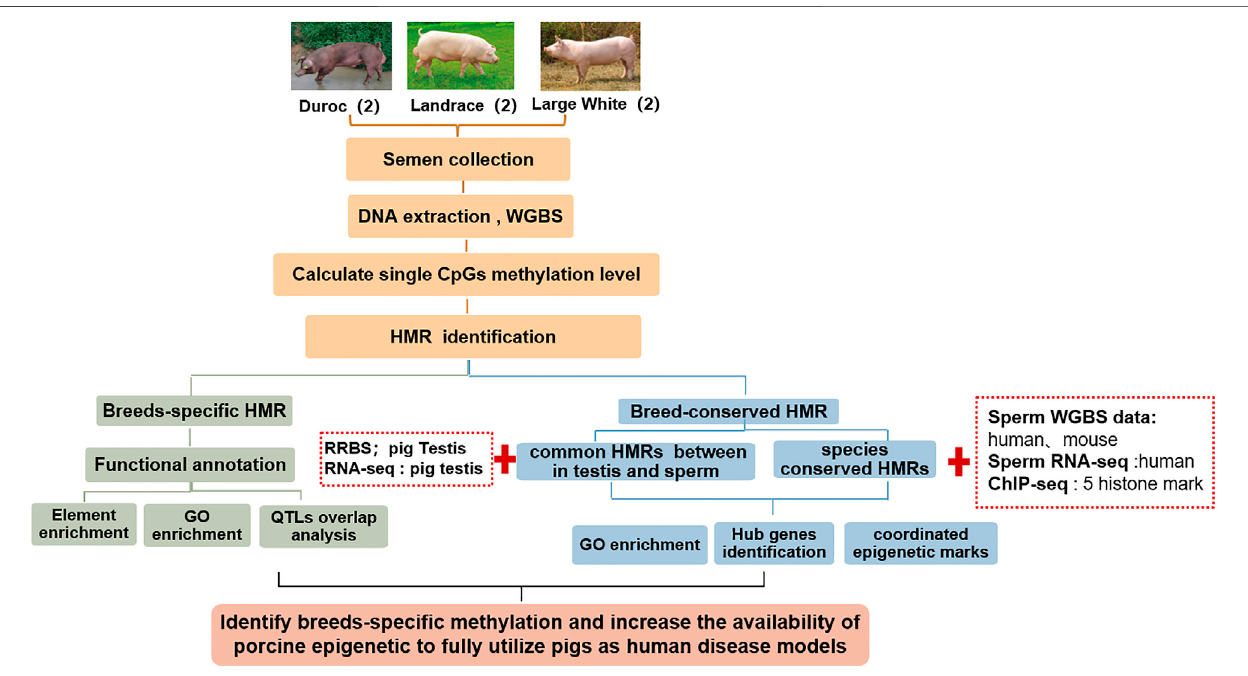
FIGURE1| Schematicoverviewofthisstudy.Weidenti fi edbreed-speci fi c/breeds-conservedHMRsofpigsusingwhole-genomebisul fi tesequencingofsixsperm samples from three pig breeds in Landrace, Duroc, and Yorkshire. Thereafter, we annotated them by integrating GO/KEGG, traditional quantitative trait loci (QTL) and transcriptional factor binding sites. Finally, we analyzed changes of HMRs in mammalian evolution by integrating WGBS public data on humans and mice.